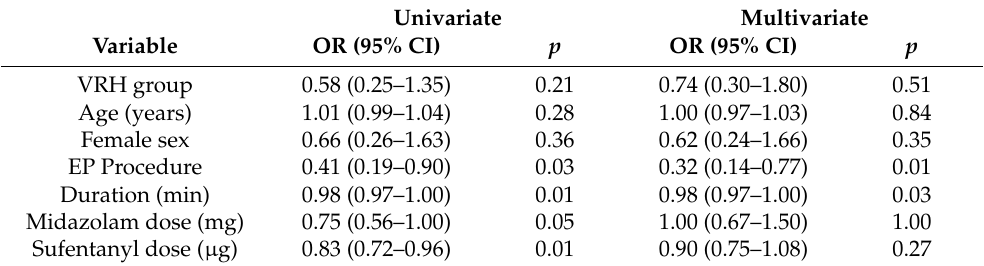
Table 4. Univariate and multivariate analysis results for VRH use regarding the perception of procedural pain assessed with a postoperative visual analogue scale (VAS). VRH: virtual reality hypnosis; EP procedure: electrophysiological procedure; OR: odds ratio; CI: confidence interval.